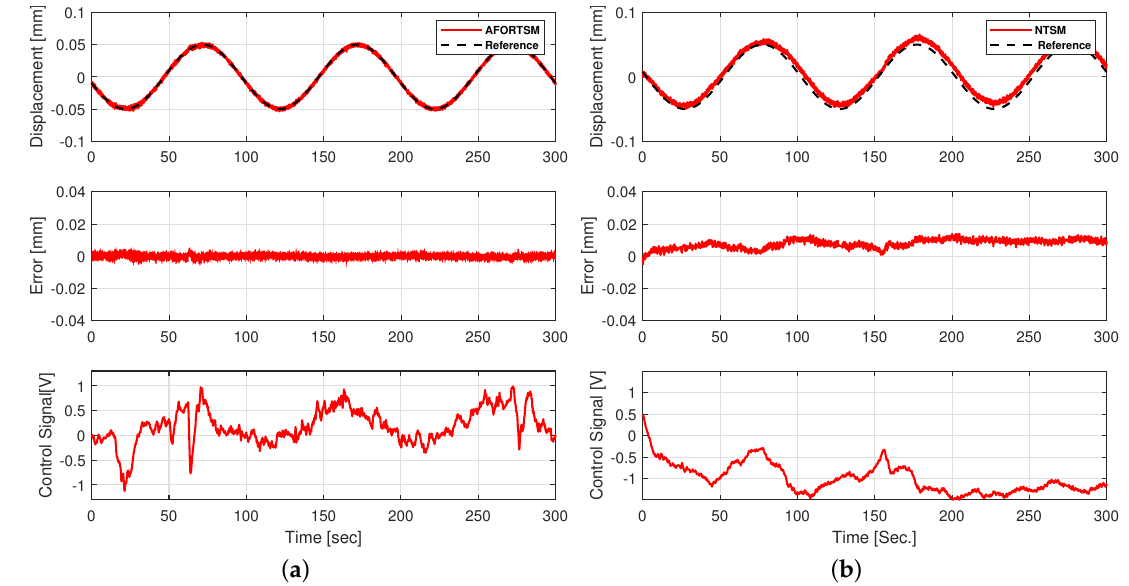
Figure 7. Test 6: Experimental results of AFORTSM and NTSM for tracking a single-tone sinusoidal reference with uncertainties (top: tracking profiles; middle: tracking error; bottom: control signal). ( a ) AFORTSM; ( b ) NTSM.